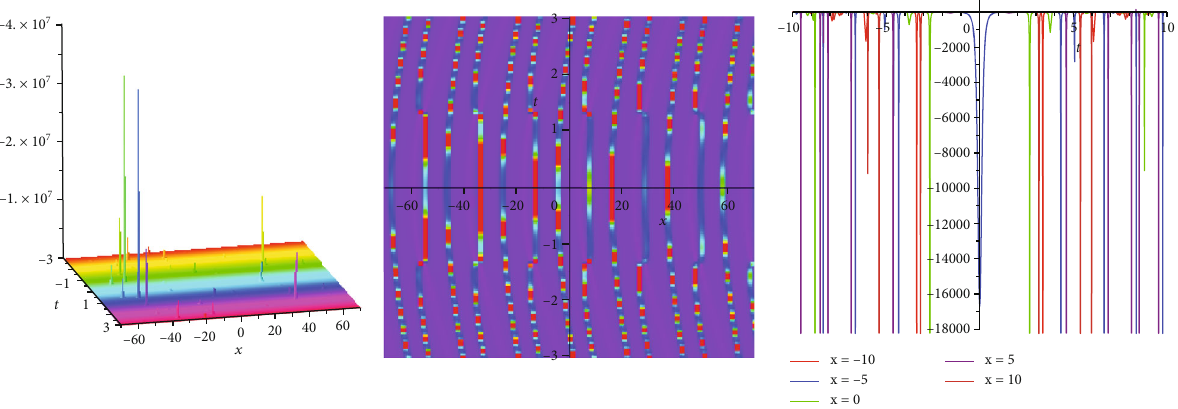
Figure 4: Plot of periodic wave solution (35) ð Σ